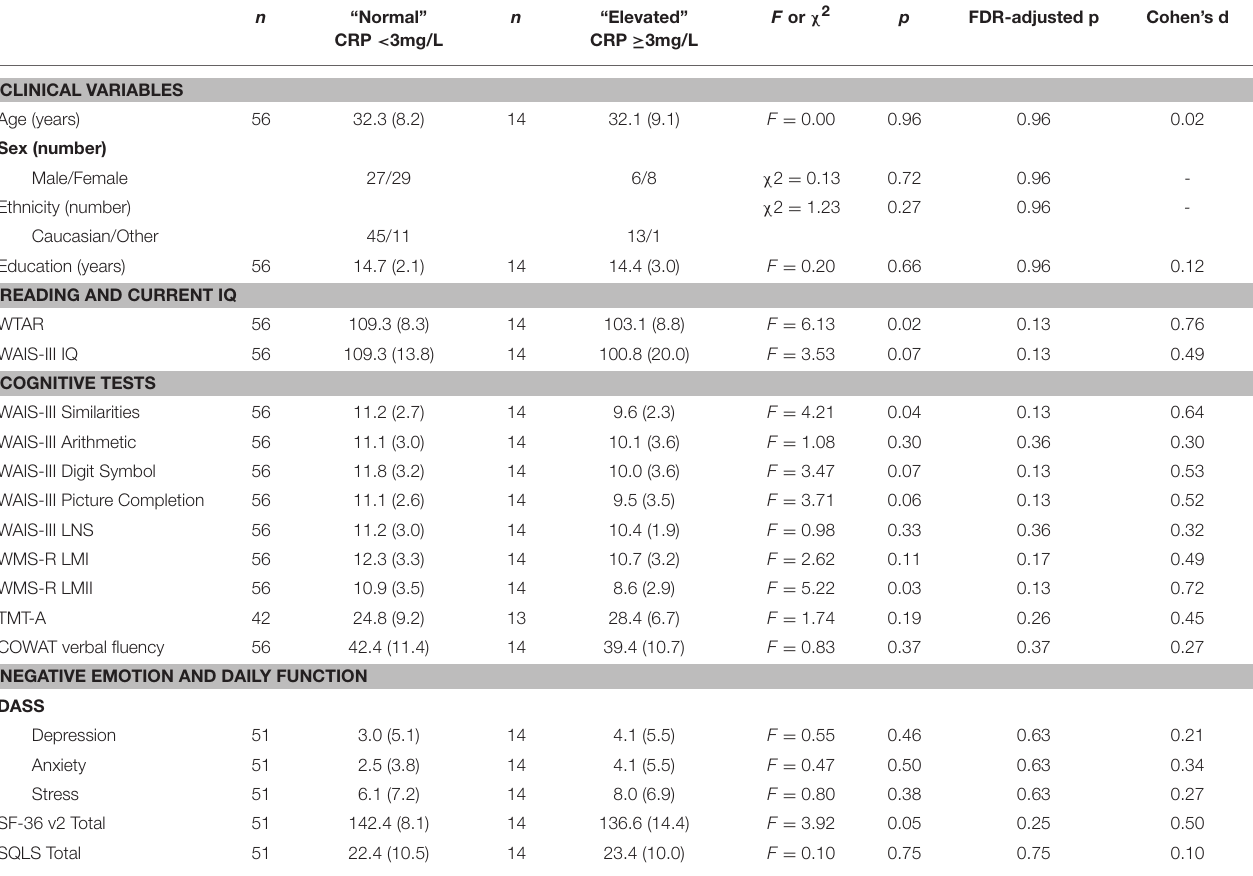
TABLE 8 | Comparison of demographic, cognitive, negative emotional states, daily function, and quality of life measures between normal and elevated CRP groups in healthy controls. n “Normal” n “Elevated” F or χ 2 p FDR-adjusted p Cohen’s CRP < 3mg/L CRP ≥ 3mg/L